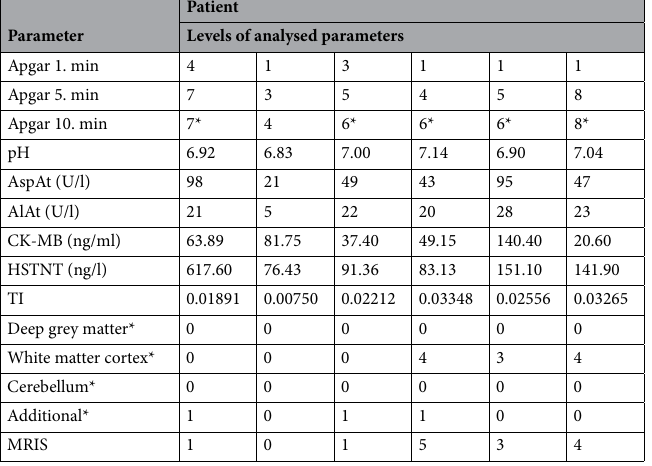
Table 2. Levels of analysed parameters in patients 1–6. *Artificial ventilation for neurological reasons needed in the 10th minute after birth * Weeke scale, MRIS MRI Score.